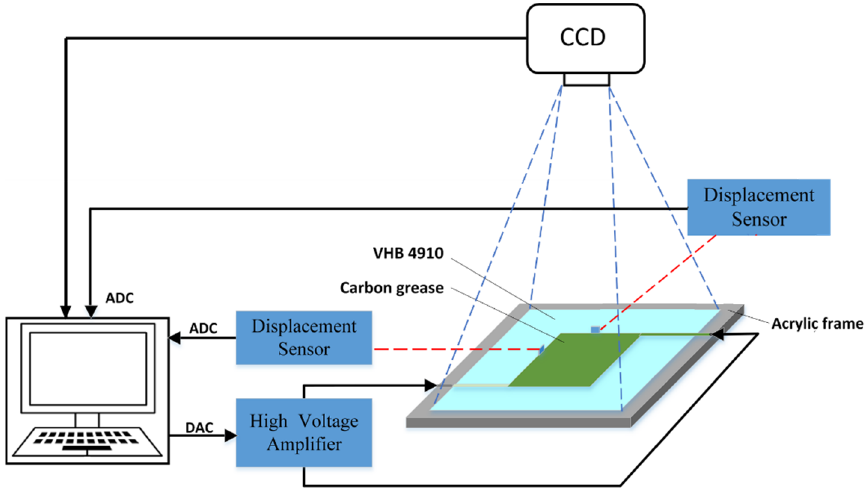
Figure 3. The experimental setup.